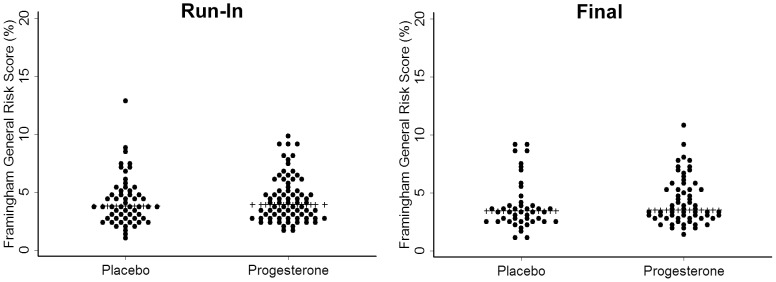
Changes in Framingham General Cardiovascular System Profile [26] 10-y Risk Score.These data are from 108 untreated healthy postmenopausal women (1–11 years since their last menstrual flow) in a randomized controlled trial of oral micronized progesterone (300 mg daily, Progesterone; n = 63) or identical placebo (Placebo, n = 45) for treatment of hot flushes/flashes and night sweats. This pair of dot-plots shows women's Framingham General CVS Profile during run-in by assignment to Progesterone or Placebo (left panel) and at the end of 12-weeks of experimental therapy (right panel). None of these differences were statistically significant.